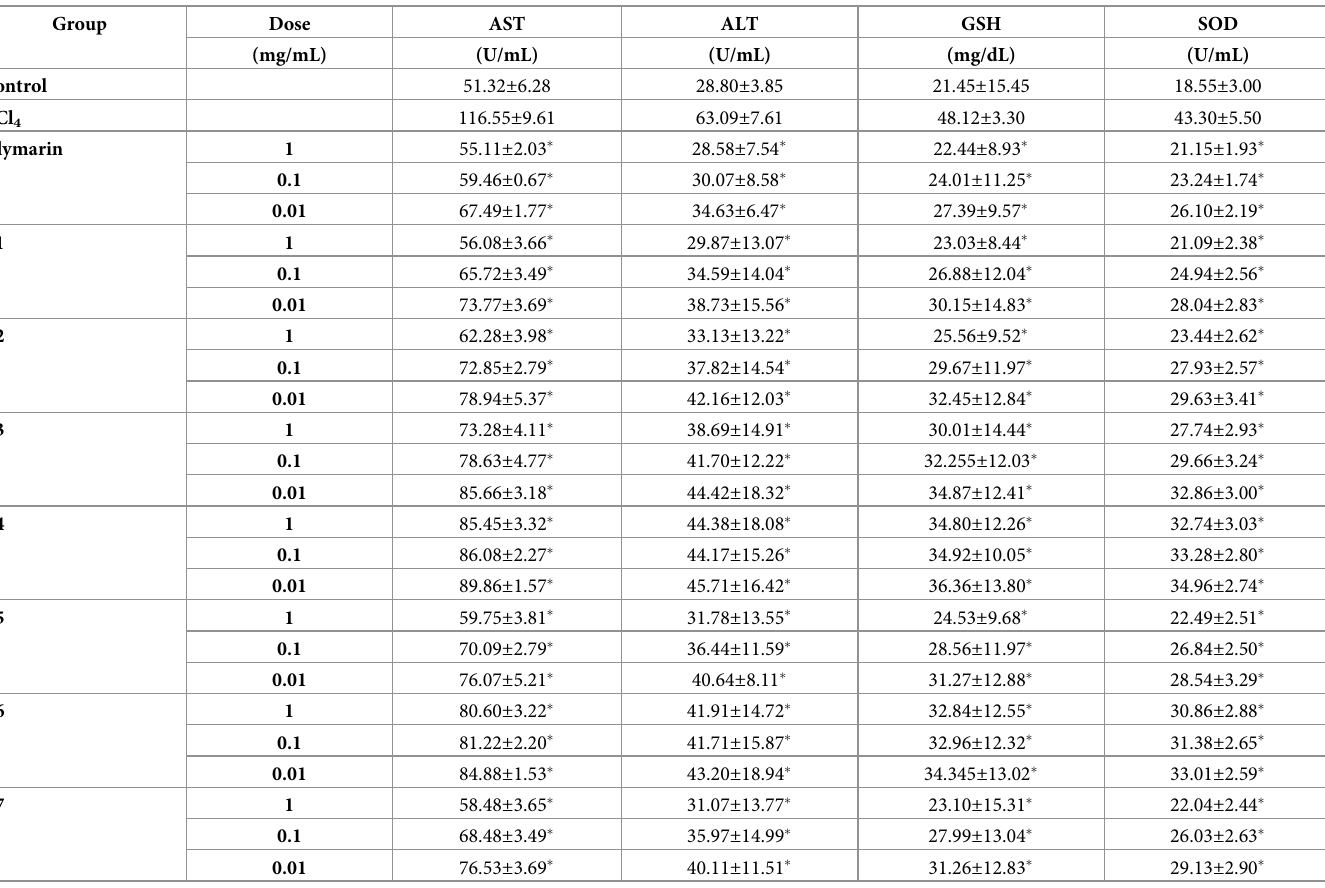
Table 4. Protective effect of the isolated compounds from P . niruri on CCl 4 induced toxicity in Hepg2 cell line.